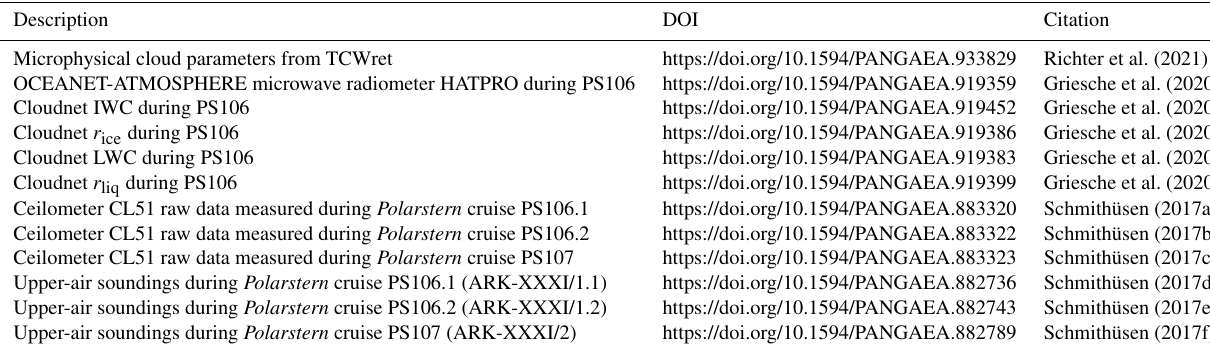
Table 7. Datasets used in this publication.